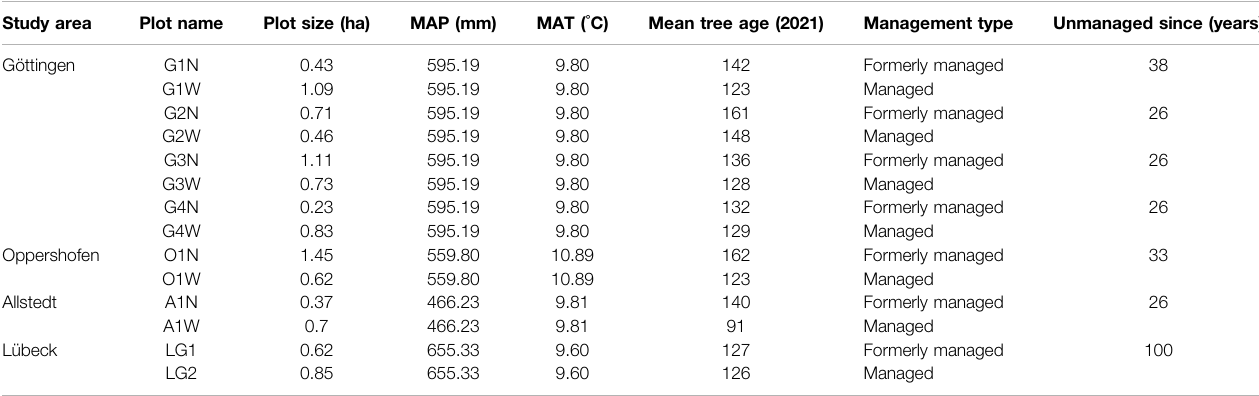
TABLE 1 | Detailed information about the climatic and geographic conditions of the study areas and the average age of the studied stands. Study area